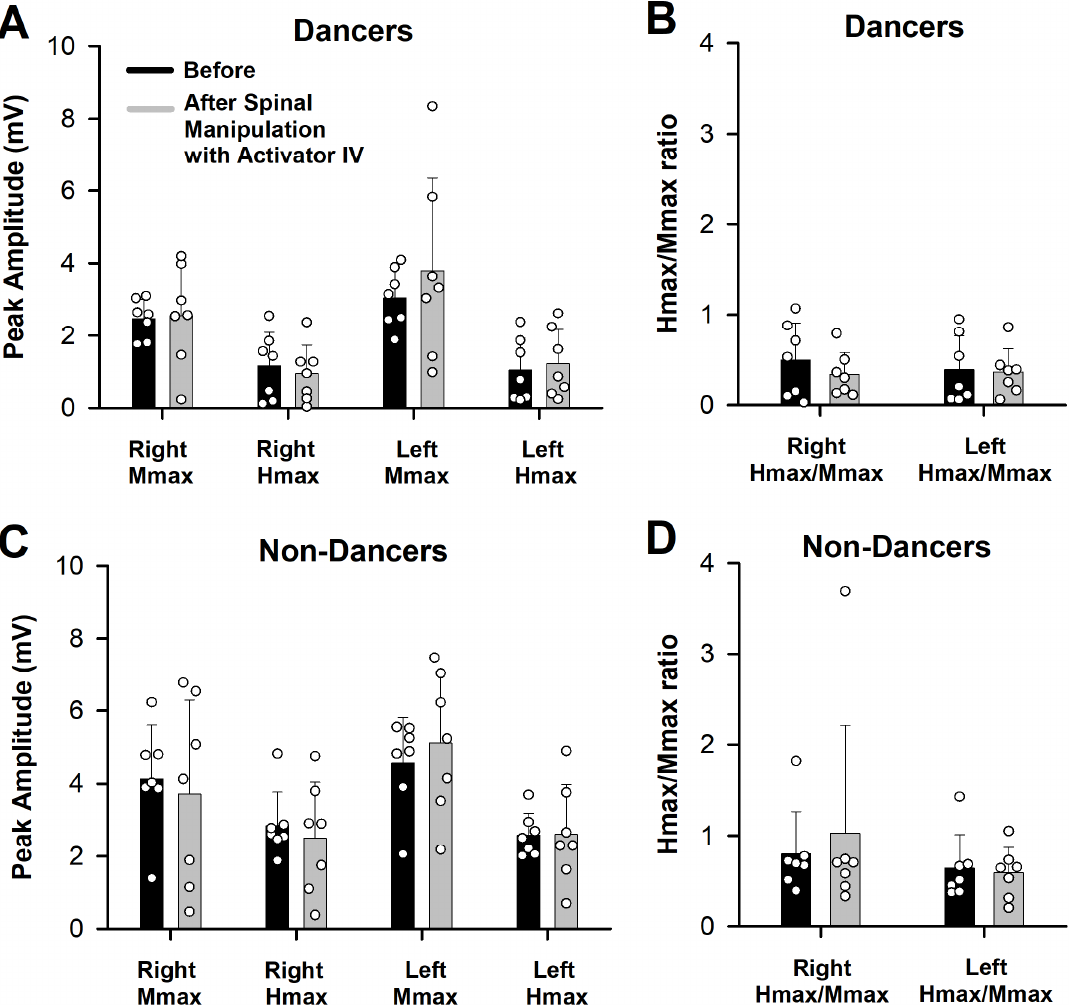
Figure 2. An absence of changes in bilateral Mmax, Hmax, and Hmax/Mmax was found for dancers ( A , B ) and non ‐ dancers ( C , D ) after spinal manipulation with Activator IV. Bar charts are the mean values. Vertical bars indicate the standar deviation. The white circles illustrate raw data obtained from all participants.